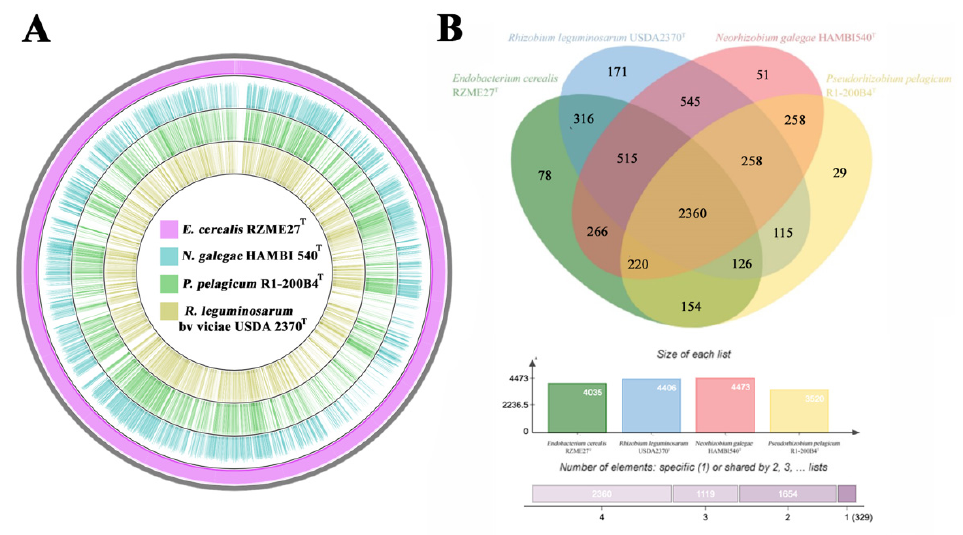
Figure 4. Comparative genomics among the genomes of E. cerealis RZME27 T , N. galegae HAMBI 540 T , P. pelagicum R1-200B4 T and R. leguminosarum USDA 2370 T . ( A ) Schematic representation of BLAST comparisons amongst the four type species. From the outer to the inner circle: RZME27 T (pink), HAMBI 540 T (blue), R1-200B4 T (green) and USDA 2370 T (gold). ( B ) The Venn diagram and the bar chart below show the number of shared and unique orthologous amongst the four genomes.